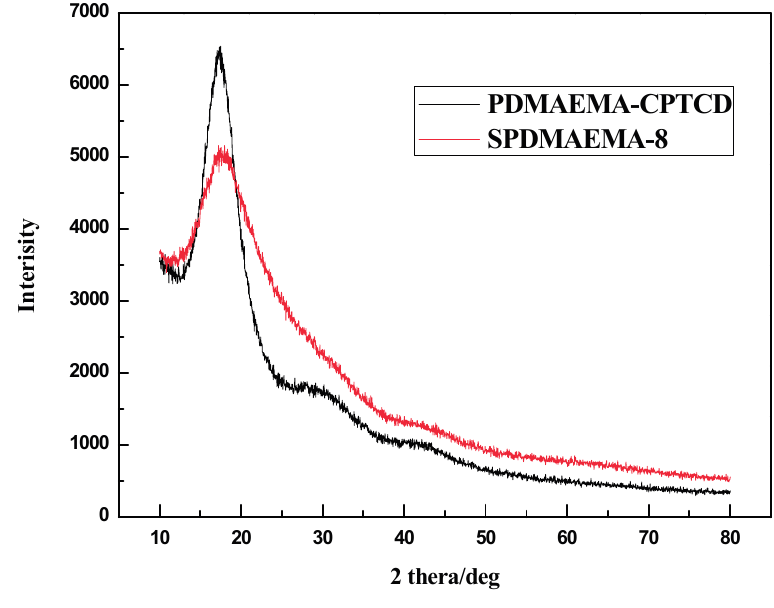
Figure 7. The XRD traces of PDMAEMA-CPTCD and SPDMAEMA-8.